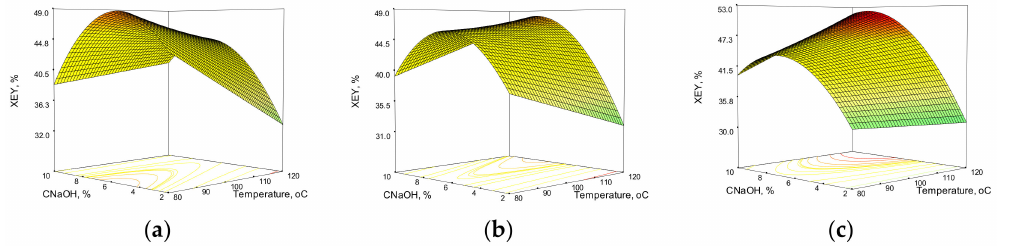
Figure 3. Response surfaces and contour plots of the combined effects of sodium hydroxide con- centration and temperature on xylan extraction yield from corn stalks at various reaction times: